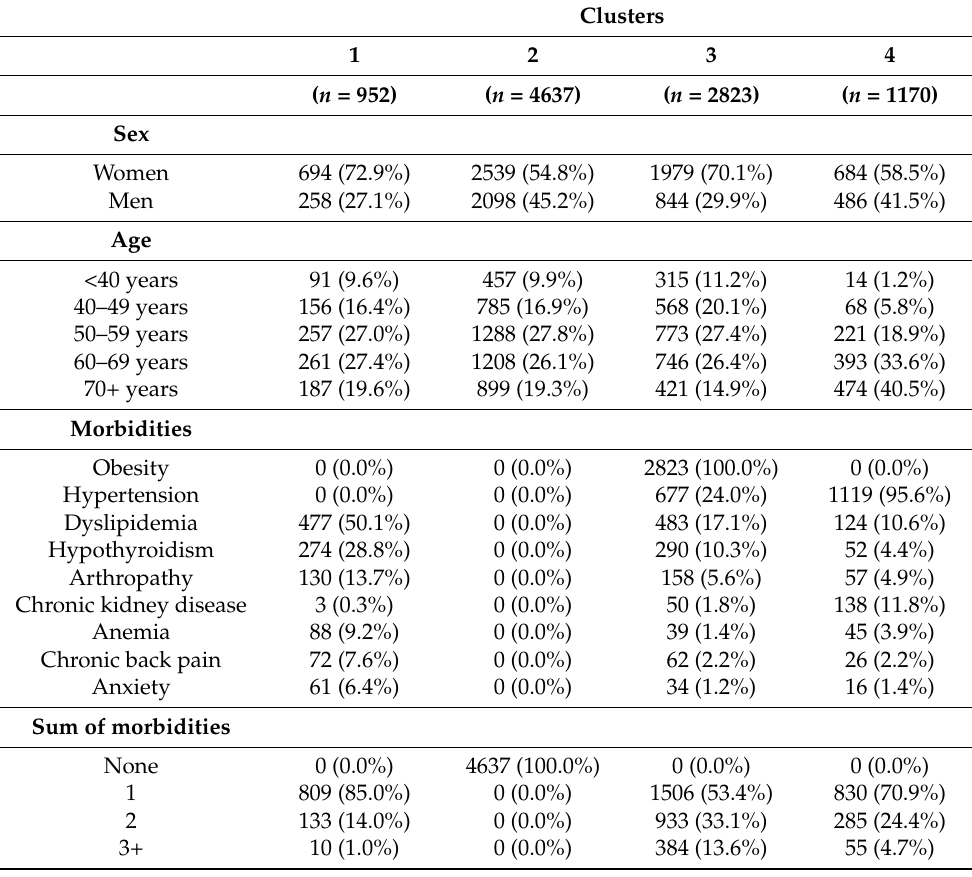
Table 2. Cluster analysis (k-means): Characterization of